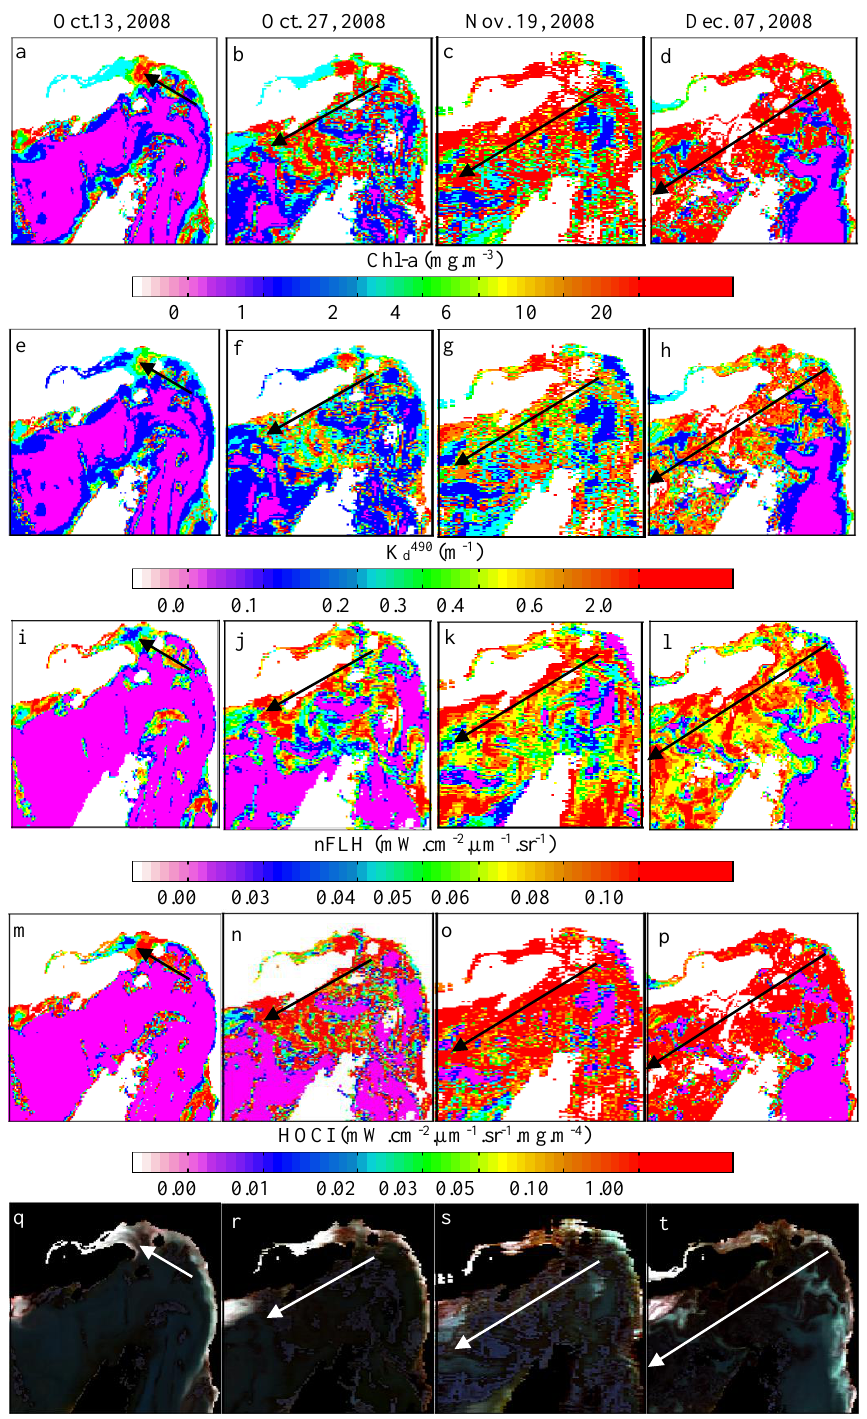
Figure 4. Classification maps of Chl-a, K d490 , nFLH, and HOCI plus to ERGB images in the Strait of Hormuz during four days from October to November in 2008. Black and white vectors track the path of bloom